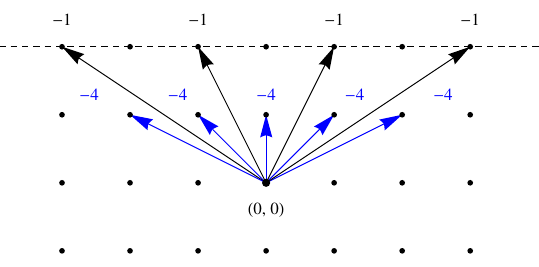
Figure 6 . Primitive rays associated with a face of the toric base polytope at distance 2 from the origin give a sequence of toric curves of self-intersection (cid:0) 1 ; (cid:0) 4 ; (cid:0) 1 ; (cid:0) 4 ; : :